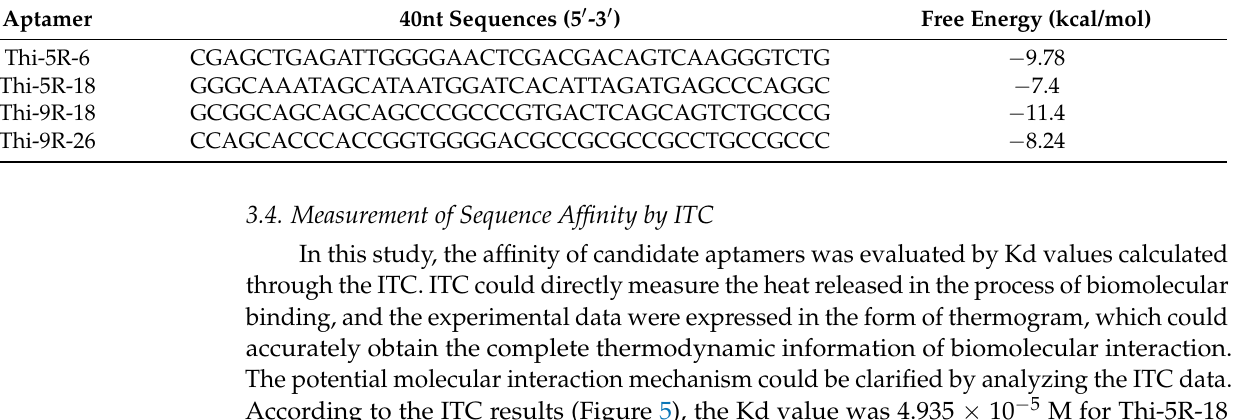
Figure 4. The secondary structures of aptamer candidates. Table 1. Sequences of aptamer candidates.